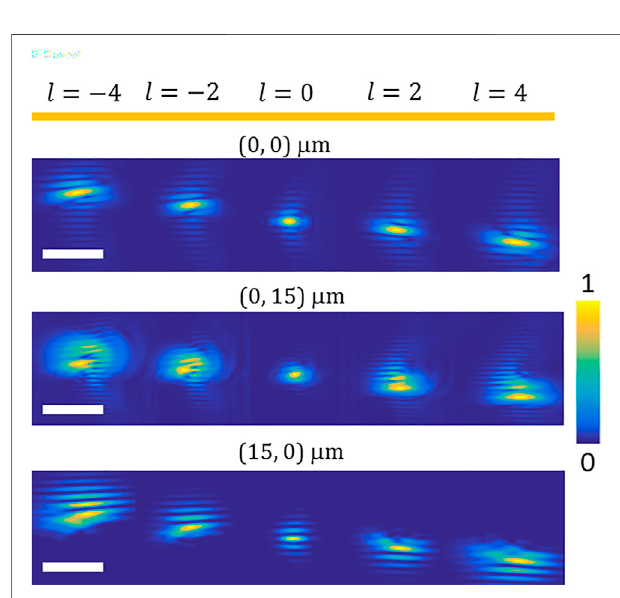
FIGURE 7 | OAM modes of l (cid:2) 0 , ± 2 , ± 4 reaching the detector upon various lateral displacements. Scale bars, 60 μ